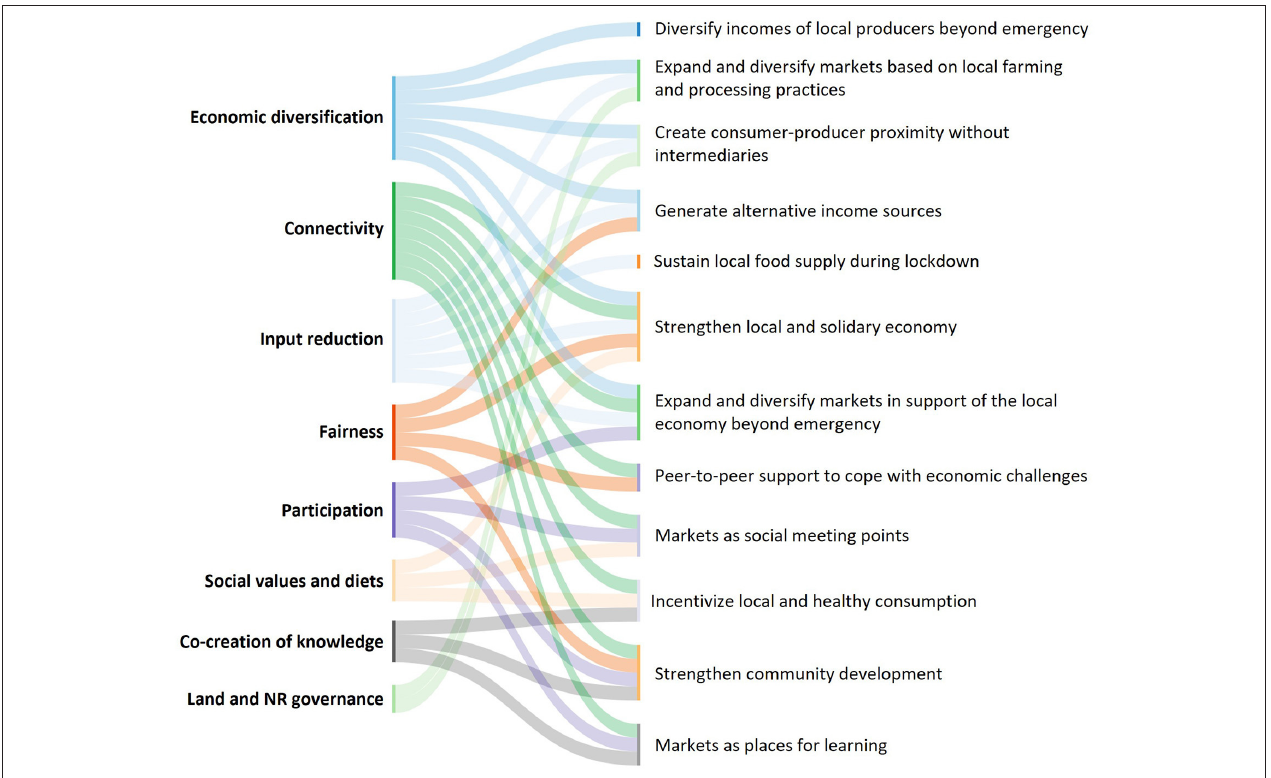
FIGURE 4 | Assignment of SOPGs’ objectives and agroecological